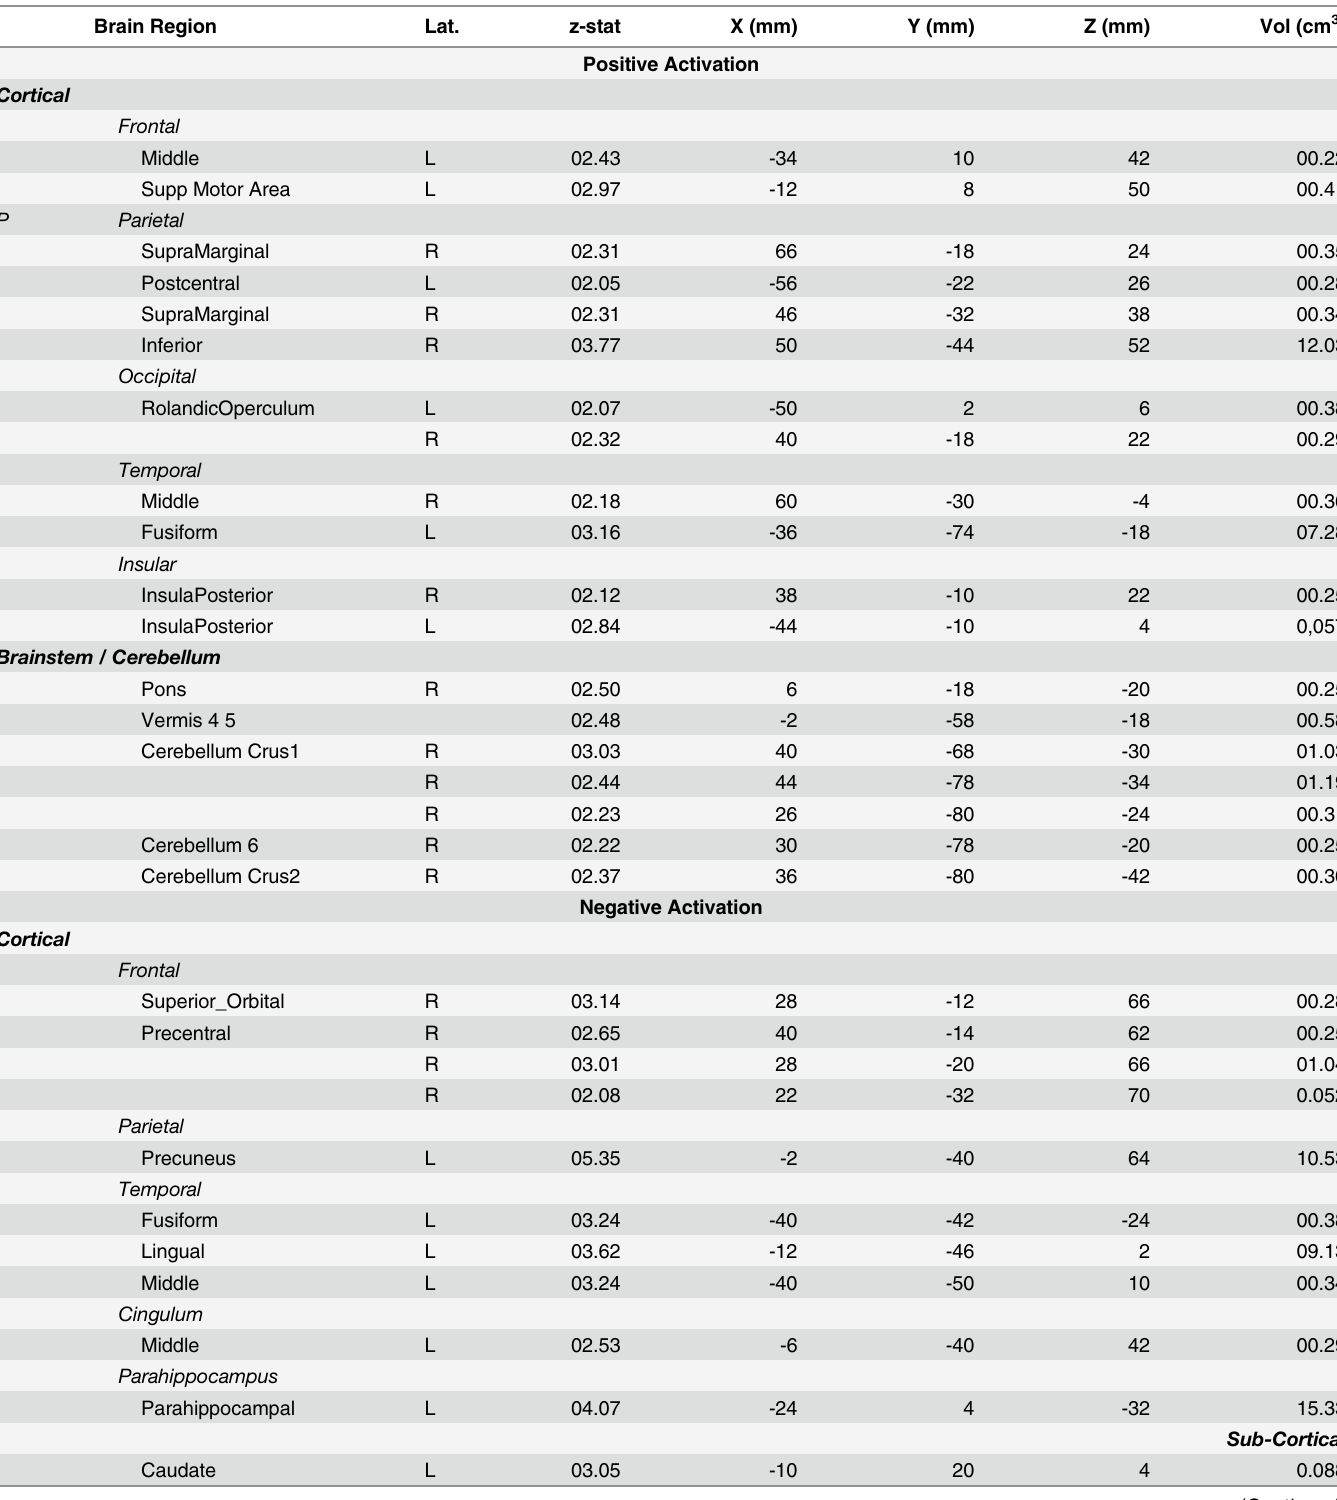
Table 2. Contrast analysis results for painful heat functional MRI activation at baseline (before infusion of CGRP). NOTE: Two ROIs usually active in pain (anterior cingulate cortex and anterior insula) are not identified due to the distortion of the images. Brain